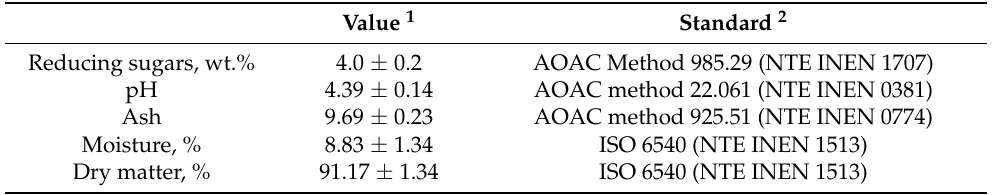
Table 1. Physical-chemical analysis of dehydrated samples of coffee residues. Value 1 Reducing sugars,